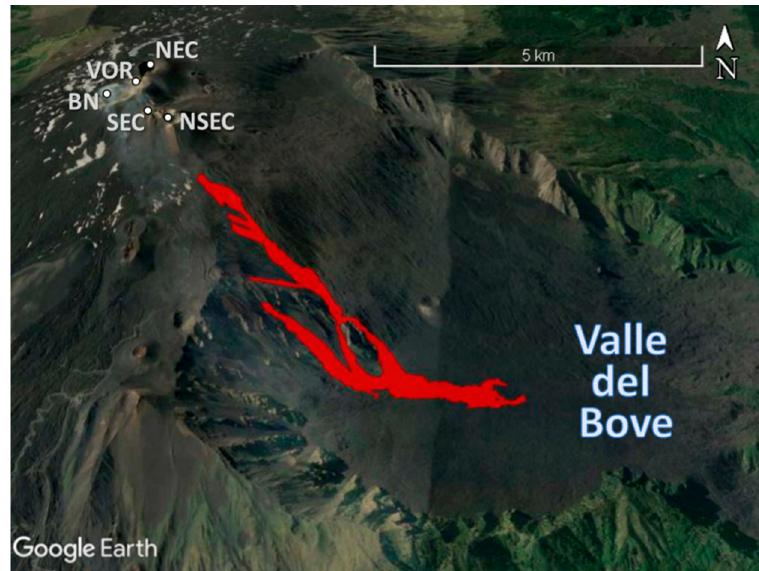
Figure 1. Reference lava flow erupted during the 2018 eruption at Mt. Etna. The lava areal coverage was extracted by the PlanetScope image acquired on 29 December 2018. North-East Crater (NEC), Voragine (VOR), Bocca Nuova (BN), South-East Crater (SEC), and New South-East Crater (NSEC) are the summit craters of Etna. Valle del Bove is the large depression on the eastern flank of the volcano. This figure was generated using Google Earth.